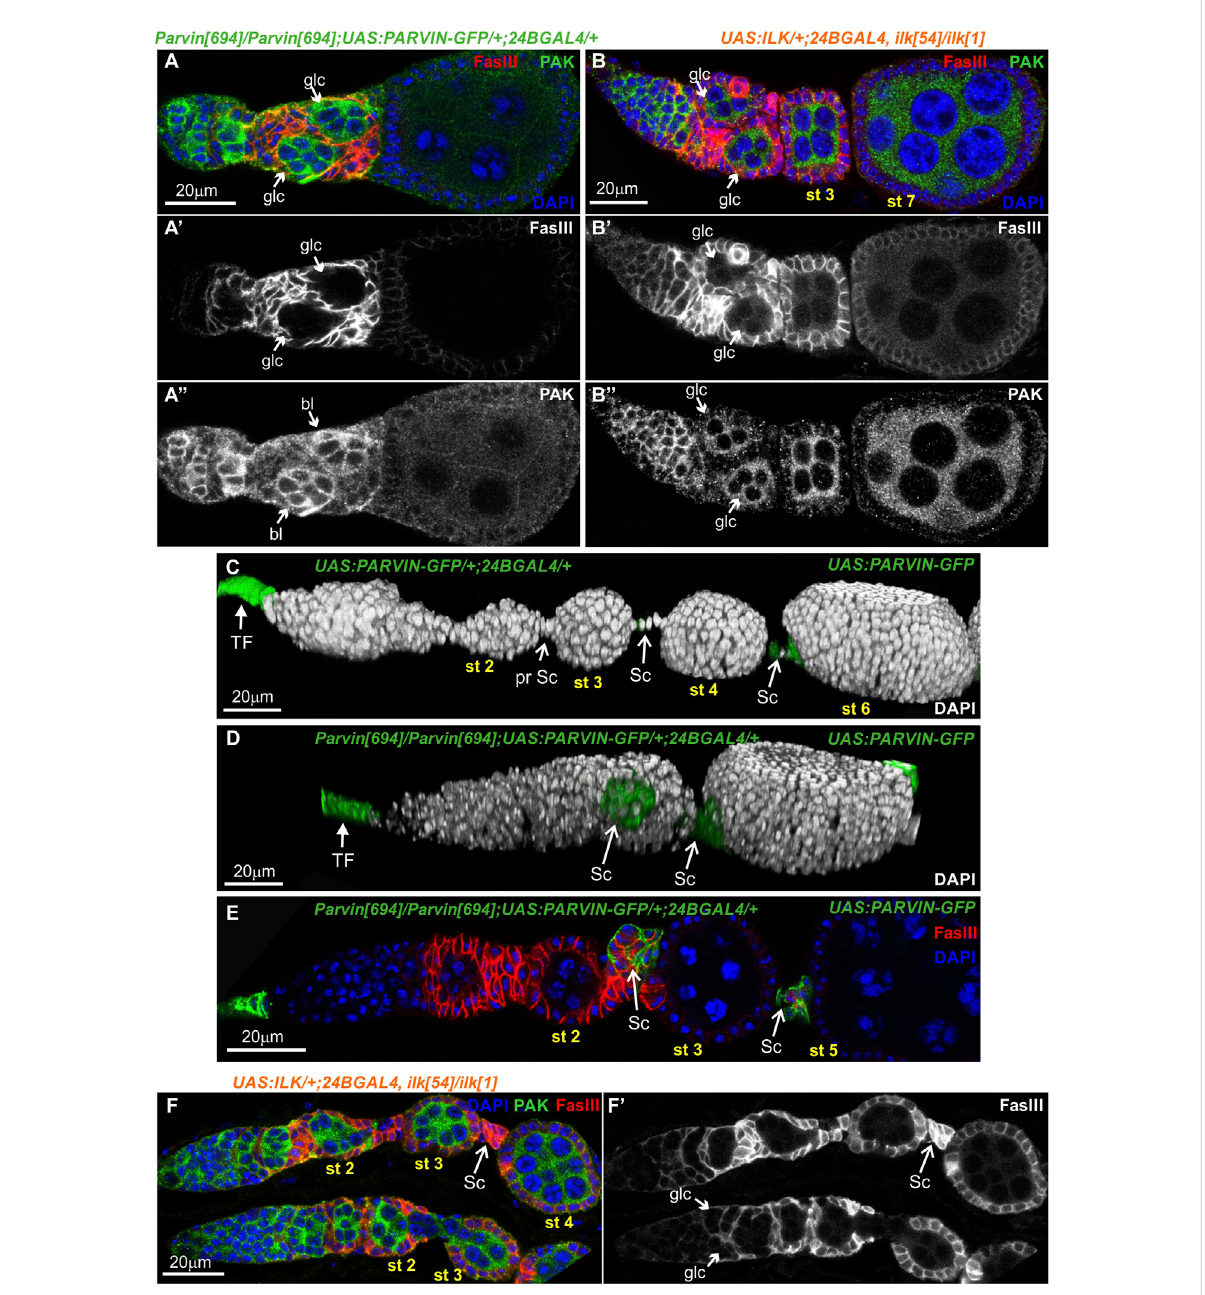
FIGURE 6 Parvin and ILK are required in the pre-follicle epithelial cells to facilitate germline cyst encapsulation and interfollicular stalk morphogenesis. 24BGal4 -rescued adult mutant fl ies for either Parvin or Ilk null alleles exhibit germline cyst and stalk organization defects in the germaria. (A-B") Confocal micrographs of ovarioles and egg chambers derived from 24BGal4 -rescued adult fl ies for (A-A") Parvin and (B-B") Ilk contain two cysts in theregion2bofthegermarium. (C,D) 3Drenderingofrepresentativeovarioles derivedfrom (C) adult fl iesthatexpressonecopyof UAS:Parvin- GFP under the 24BGal4 driver and exhibit a wild type morphology for the ovariole and (D) 24BGal4 -rescued adult mutant fl ies for Parvin null allele, carryingclustersofstalkcellsintheovariole.Stalkcellswereidenti fi edbytheexpressionofParvin-GFPdrivenbythe 24BGal4 . (E,F) Cross-sectionsof ovarioles of 24BGal4 -mediated rescued adult fl ies for either Parvin (E) or Ilk (F) showing thestalk cell clusters in between stage 2 (st2) and 3 (st3) egg chambers. glc, germline cyst; TF, terminal fi lament; Sc, Stalk cell. Scale bars: 20 μ m in all